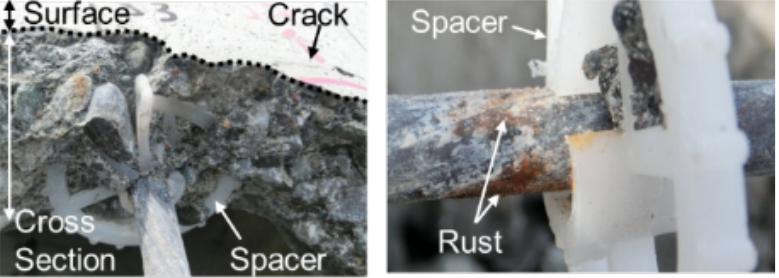
Figure 13. Observation results of cracks and spacers during dismantling of the utility pole.